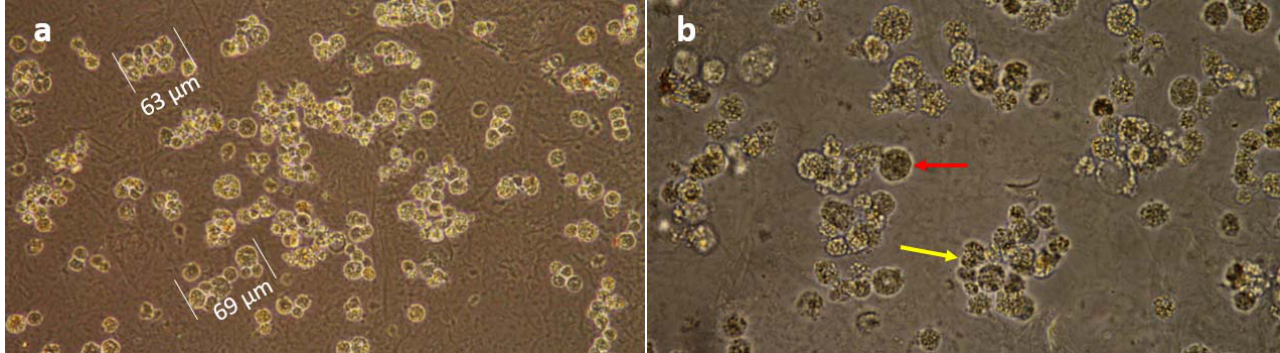
Figure 4. Light microscopy of passage 33 BmVIII-SCC cells cultured with the hydrogel matrix showing aggregate formation. ( a ) Measurements of small granular endothelial-like cell aggregates of “mortar stone” morphology observed on day 25 p.i. at 200 × . ( b ) Large vacuolated cells with enhanced intracytoplasmic organization and dense granulation (red arrows), and aggregates of smaller granular cells (yellow arrow) were distributed throughout the matrix on day 30 p.i. as observed at 400 ×